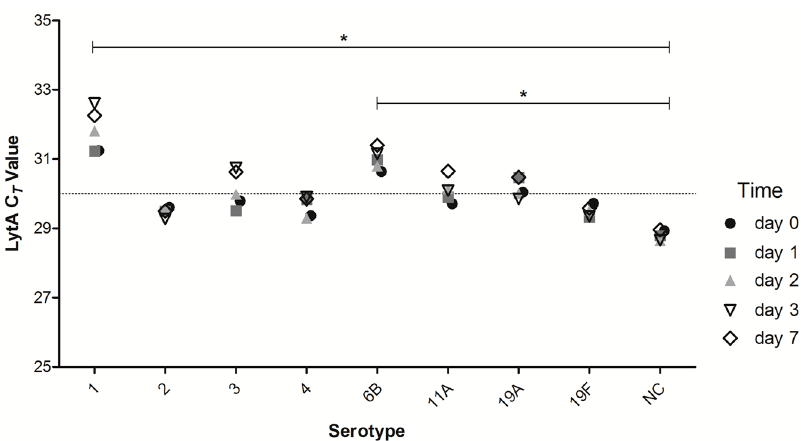
Figure 3. Effect of saliva on various strains. Saliva of 1 donor was aliquoted and spiked with different serotype strains, after which DSS were generated. DSS were analyzed for pneumococcal-specific signal at day 0, 1, 2, 3 and 7. Dots are the mean C T of 3 experiments (different donor each experiment). DSS specimens were kept at RT for the duration of the experiment. NC: non-encapsulated strain. Stable C T values are observed for each individual serotype/strain. Comparing all serotypes, only two are significantly different: serotype 1 compared to NC and serotype 6B compared to NC (two-way ANOVA, Bonferroni post-test * p < 0.05).